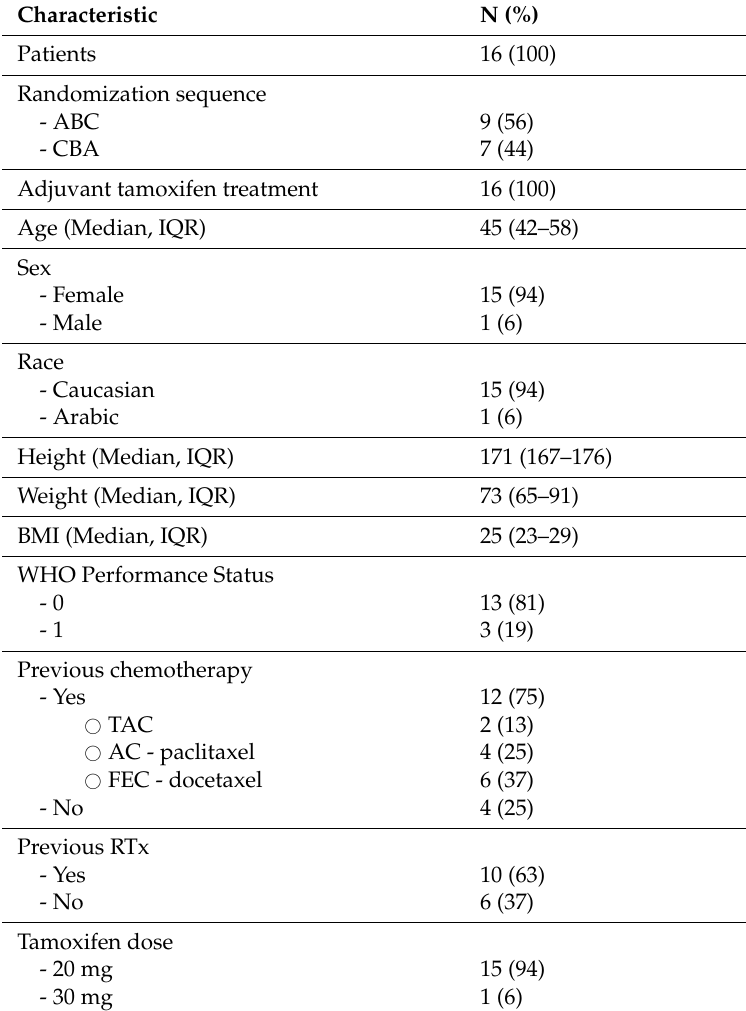
Table 1. Patient